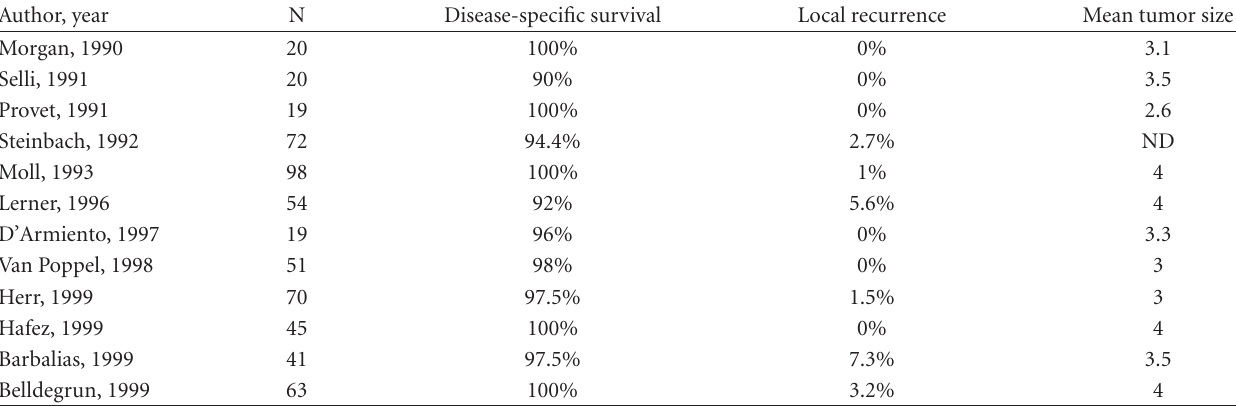
Table 1: Conservative renal surgery (partial nephrectomy); five-year outcomes in patients with elective